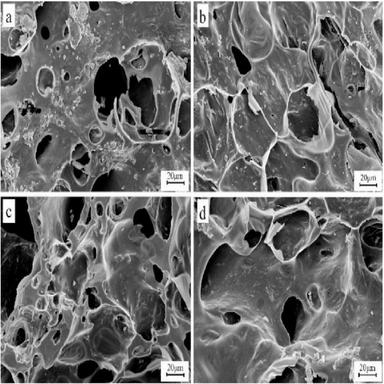
SEM micrograph of (a) S500, (b) S700, (c) S900, (d) S1100.